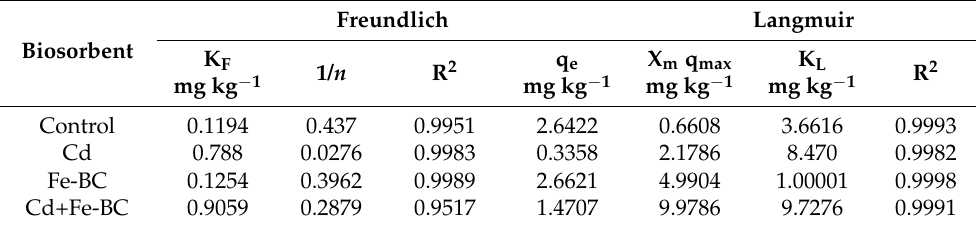
Table 3. Comparison between Langmuir and Freundlich isotherm for Cd ions biosorption onto Fe-BC under various treatments (control, Cd, Fe-BC, Cd+Fe-BC). The best model was selected based on Cd adsorption on soil–Fe-BC interface, represented as R 2 and q max values. See text for further